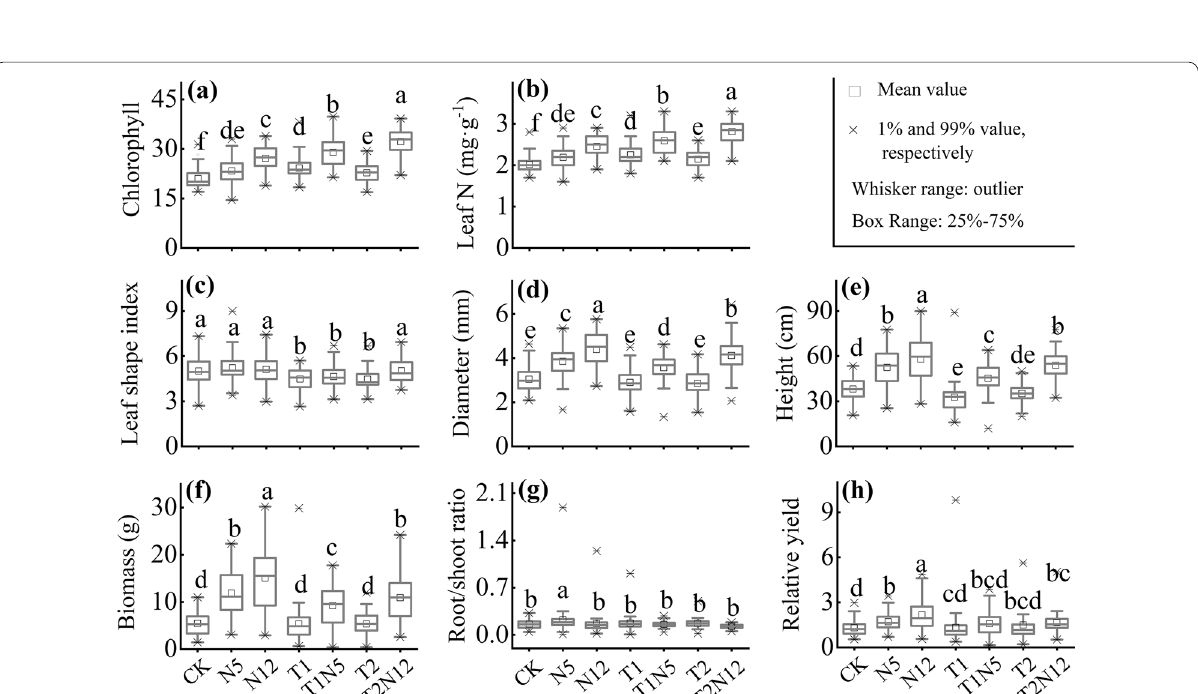
Fig. 3 Responses of growth and competitiveness of Solidago canadensis to environmental change. A total of seven environmental treatments were imposed: CK (control), N5 (N addition 5 g m -2 yr -1 ), N12 (N addition 12 g m -2 yr -1 ), T1 (temperature increase of 1.15 °C), T1N5 (combined 1.15 °C temperature increase and N addition of 5 g m -2 yr -1 ), T2 (temperature increase of 1.86 °C) and T2N12 (combined 1.86 °C temperature increase and N addition of 12 g m -2 yr -1 ). The sample size for each group in each boxplot is